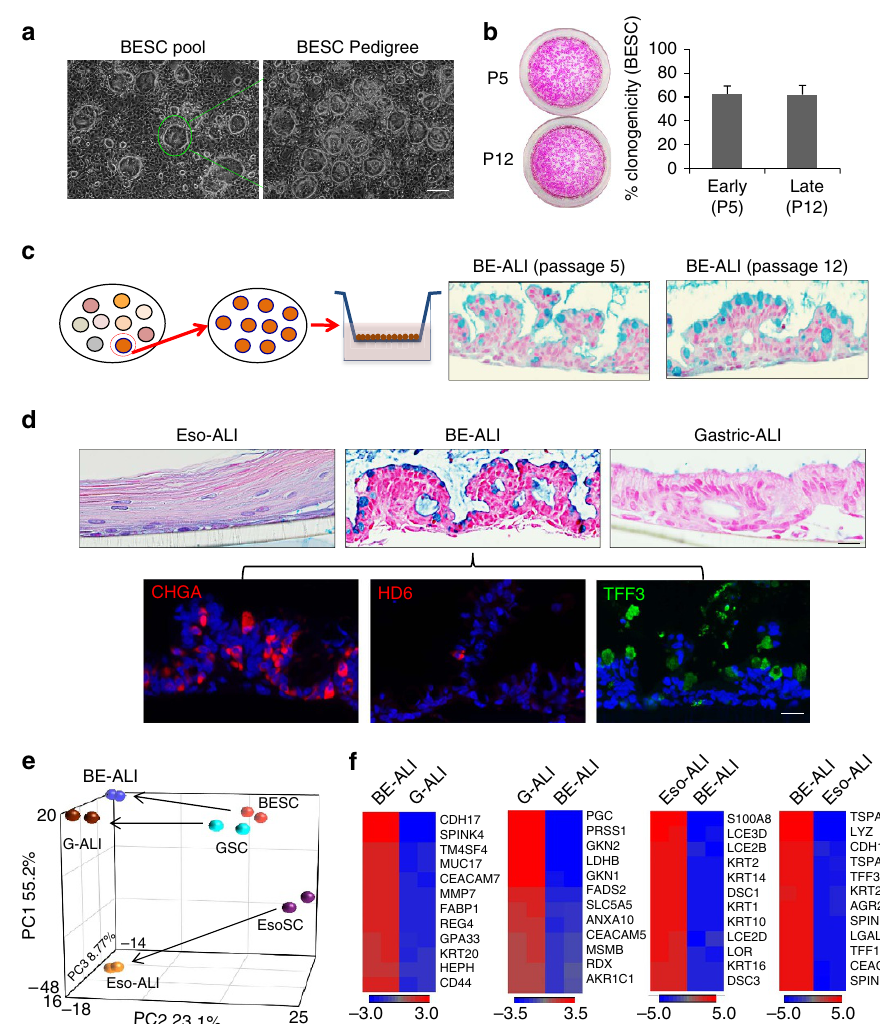
Figure 2 | Barrett’s stem cell pedigree recapitulates intestinal metaplasia. ( a ) Derivation of stem cell pedigree from pool of colonies (left) by selecting individual colony for replating and expansion (right). Scale bar, 200 m m. n ¼ 12 biological replicates. ( b ) Clonogenicity assay for BESC at passage 5 and passage 12 determined by plating 2,000 cells and counting colony formation following Rhodamine red staining. Histogram depicting colony counts. Error bars, s.d. n ¼ 3 biological replicates. ( c ) Left, schematic diagram of induced differentiation of stem cell pedigree in ALI culture. Right, histological section of differentiated p5 and p12 Barrett’s stem cells with Alcian blue-positive goblet cells. Scale bar, 100um. n ¼ 12 biological replicates. ( d ) Upper, Alcian blue staining of ALI culture differentiation of EsoSC, BESC and GSC, bottom, immunostainings of section of BESC-derived epithelium following ALI differentiation showed distribution of multiple types of cells positive for CHGA (endocrine cells), HD6 (Paneth cells) and TFF3 (goblet cells). Scale bar, 50 m m. n ¼ 12 biological replicates. ( e ) PCA of whole-genome expression data sets from EsoSC, BESC and GSC before and after ALI differentiation as indicated. ( f ) Expression heatmap of differentially expressed genes in ALI cultures as